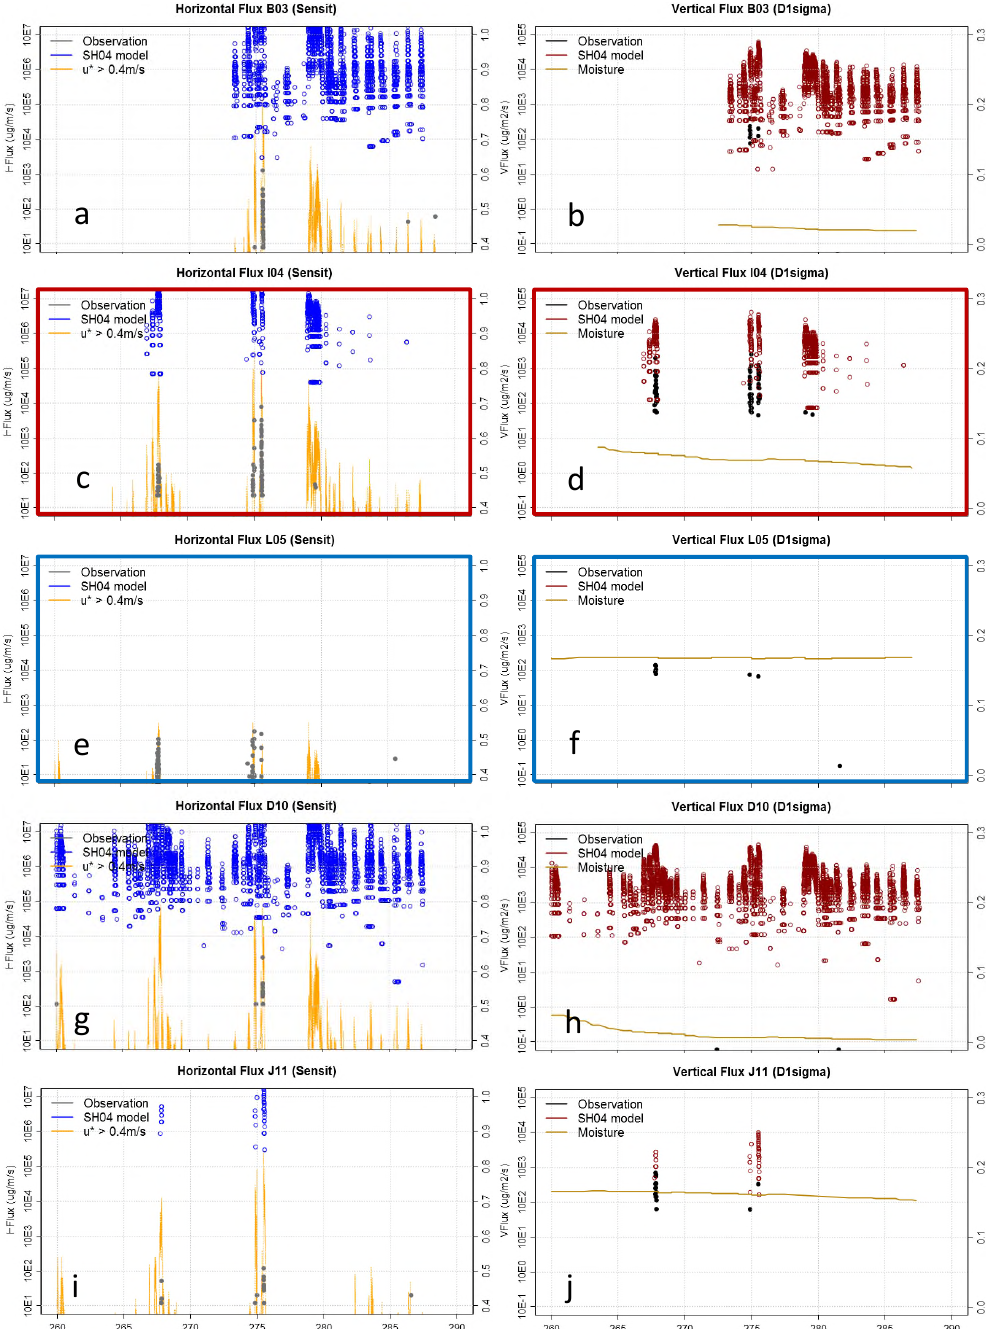
Figure 3. Same as Fig. 2 but for Exp. 4a (SH04